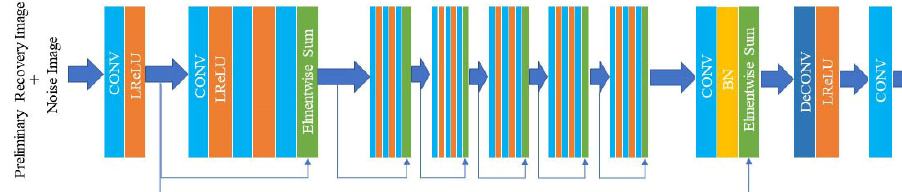
Figure 2. Convolutional network diagram.